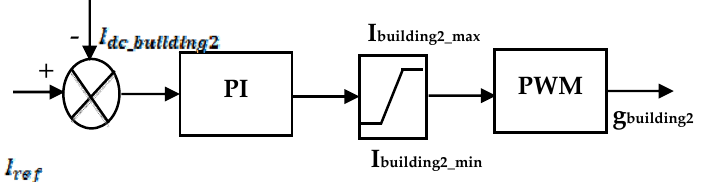
Figure 8. Control diagram of converter connected to building 2.